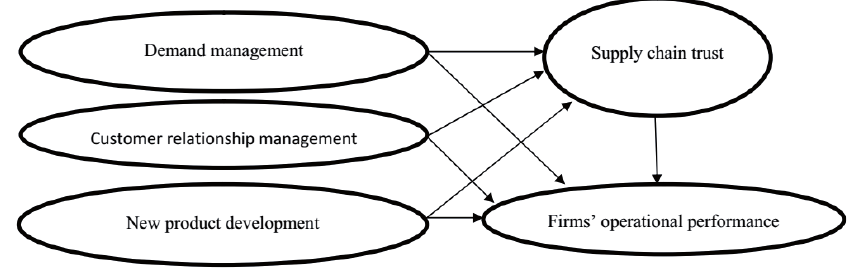
Fig. 1 – Research framework (Source: